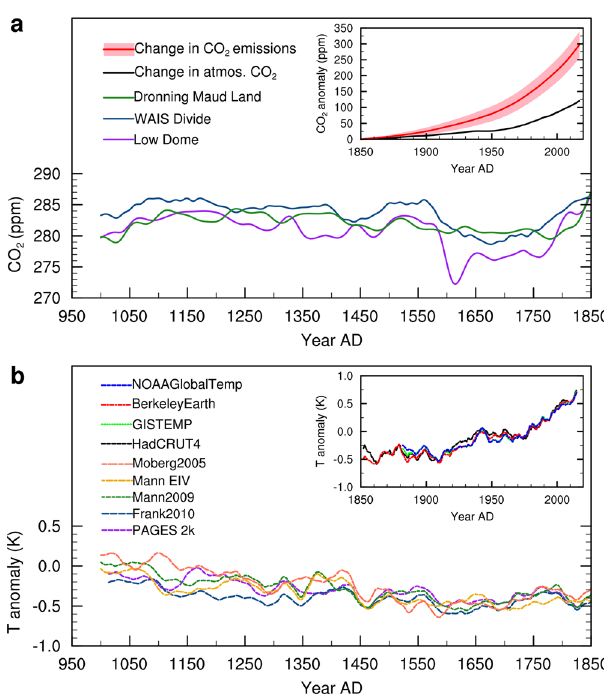
Table 1). The uncertainty in β results from the uncertainties in C